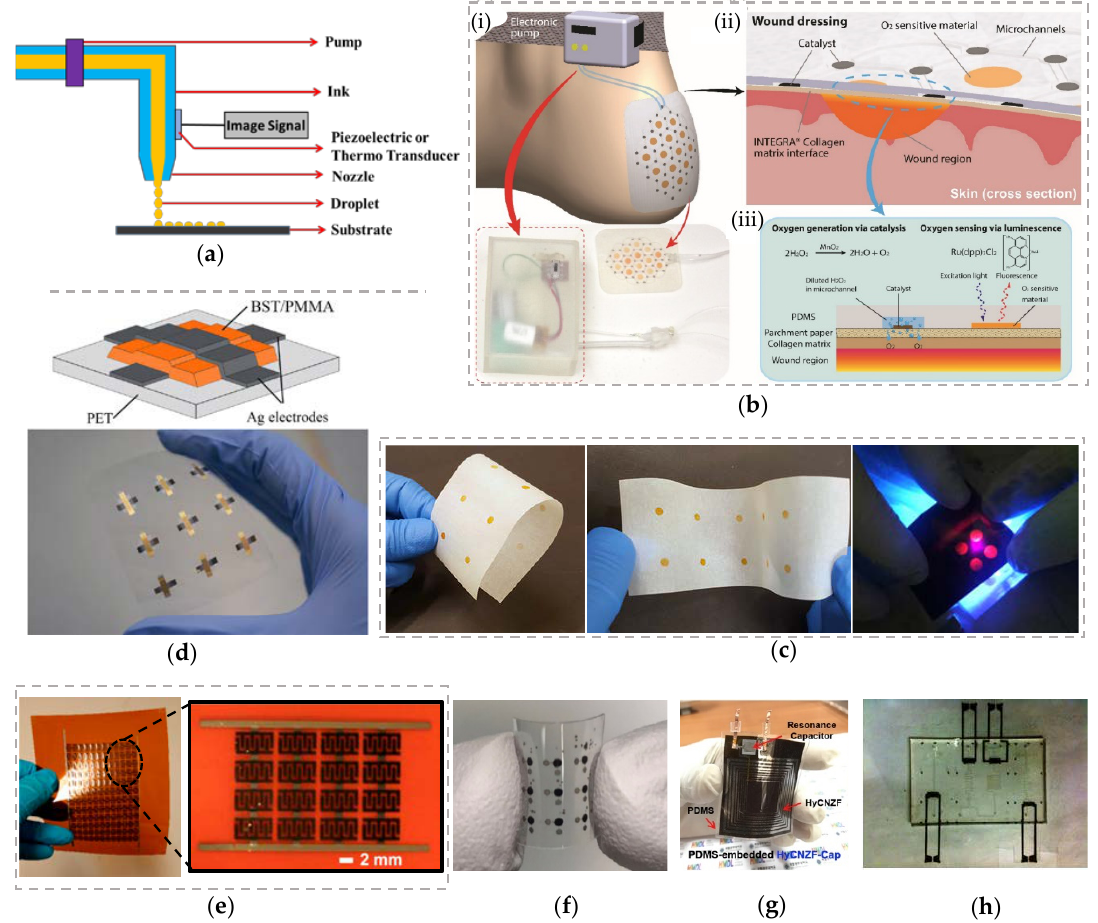
Figure 3. ( a ) Schematic of inkjet printing process; ( b ) flexible paper-based bandage with continuous oxygen delivery and sensing capabilities developed to treat the chronic wounds: (i) overview illustration of the patch in use for foot ulcer applications, (ii) cross-sectional view of oxygen generation and sensing patch and wound area, (iii) mechanisms for generating and sensing oxygen on a flexible smart wound dressing [70]; ( c ) paper-based oxygen sensors [114], Reprinted with permission from RSC; ( d ) fully inkjet-printed metal–insulator–metal capacitors [116]; ( e ) graphene-based micro-supercapacitors using electrochemically exfoliated graphene as electrodes and current collectors, Reprinted with permission from [117], © American Chemical Society; ( f ) multilayered flexible organic Schottky diode on PET substrate [118], © IOP Publishing, Reproduced with permission from IOP; ( g ) flexible wireless power transfer module (42 × 42 mm 2 ), Reprinted from [119] with permission from Elsevier; ( h ) microfluidic-based sensing platforms with inkjet-printed Ag electrodes (3.8” × 2.5” × 0.2”) [120], © IEEE, Reprinted with permission from IEEE Sensors Journal.